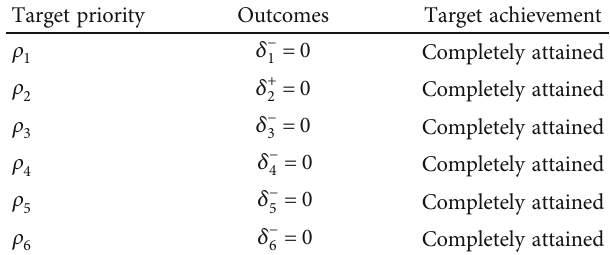
Table 4: Target achievement.